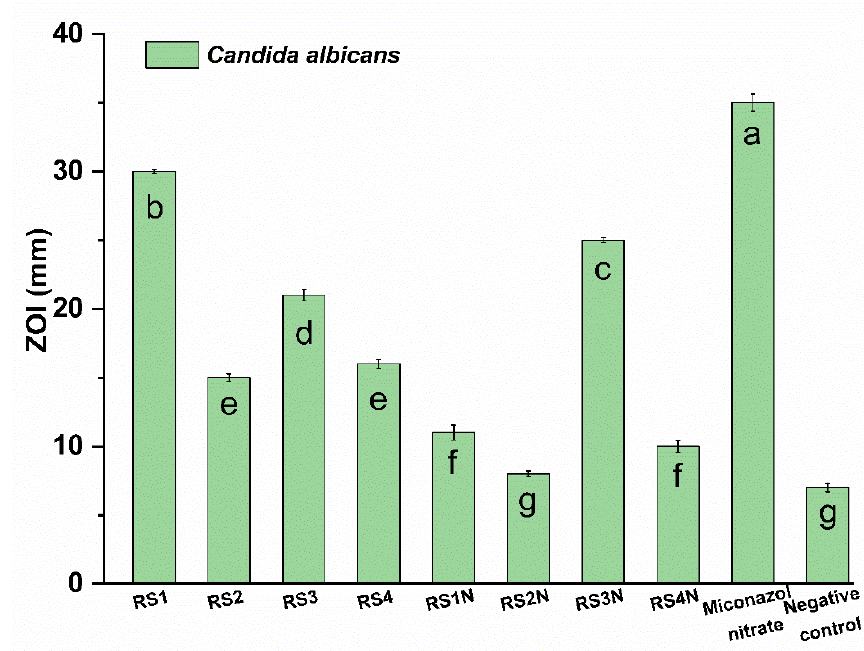
Figure 5. Anti- Candida effect of the tested samples. Values without a common letter differ ( p < 0.05) as analyzed by one-way ANOVA and the Tukey test.